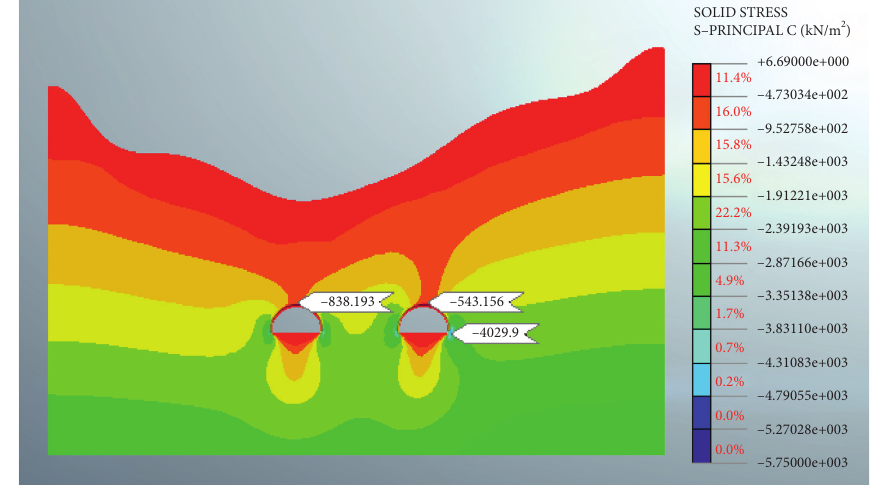
Figure 18: Large principal stress distribution of surrounding rocks in single-side guide pit